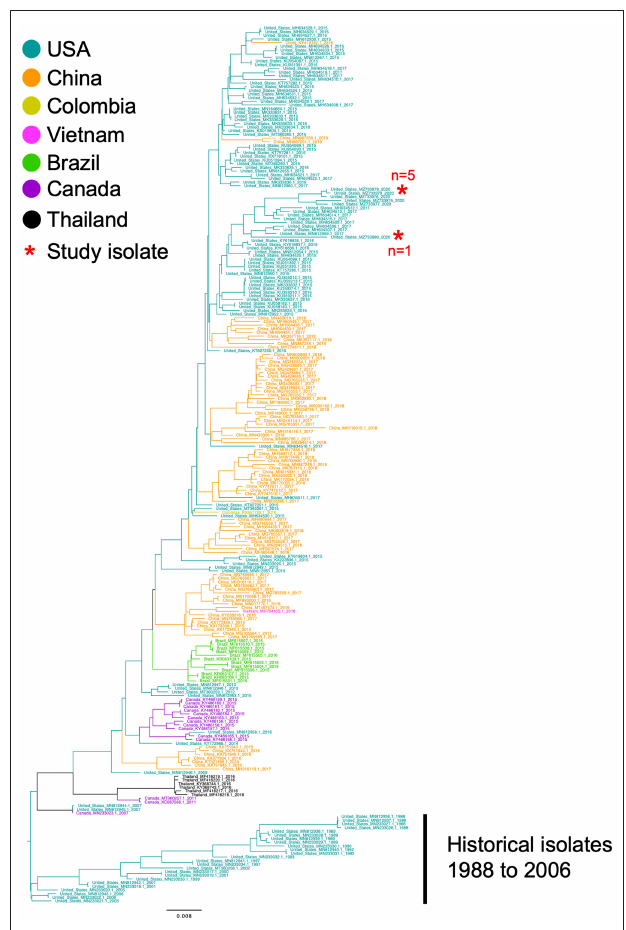
FIGURE 2 | Phylogenetic analysis of 233 SVA whole genomes and the six 2020 SVA isolates from Plants 1-3. The tips of the tree are color coded to the country of sequence origin. The six SVA genome sequences analyzed in this study are noted with a red